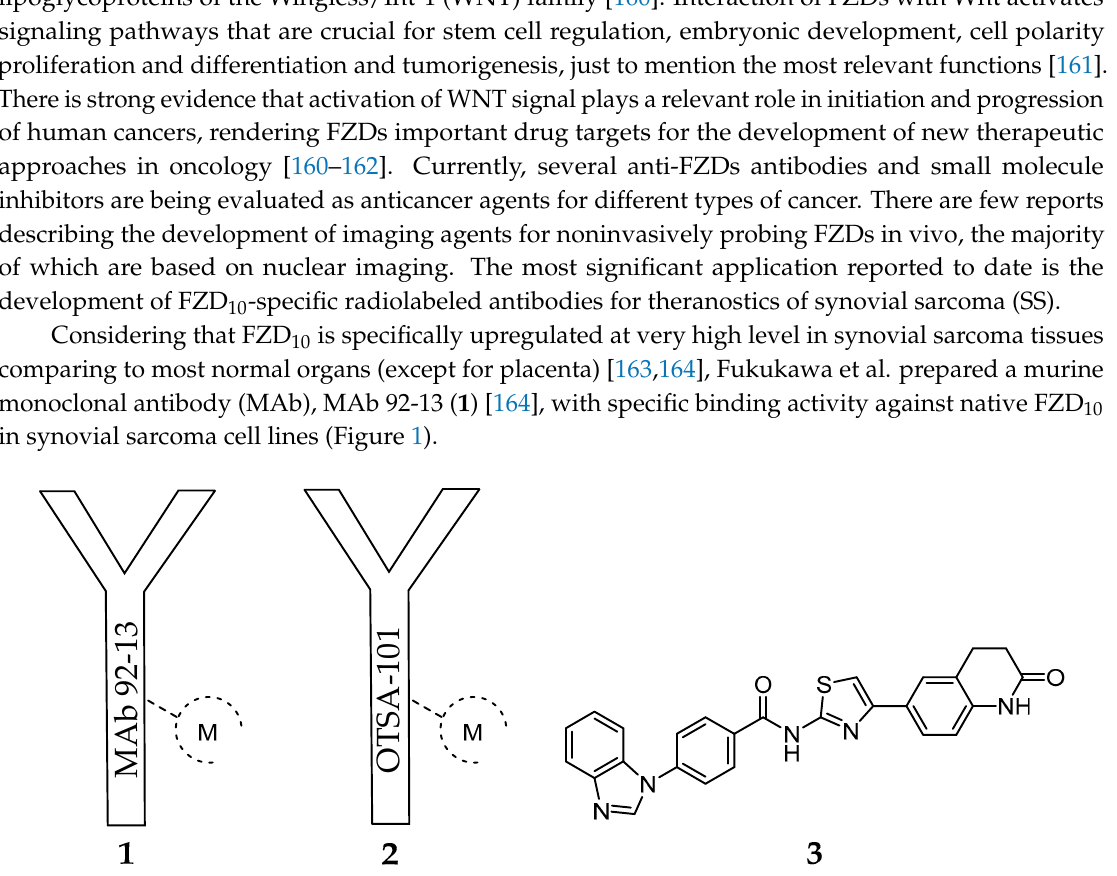
Figure 1. Frizzled receptor (FZD)-targeting molecules. MAb 92-13 ( 1 ): [ 111 In]- 1 (M = 111 In), [ 90 Y]- 1 (M = 90 Y); OTSA-101 ( 2 ): [ 111 In]- 2 (M = 111 In), [ 90 Y]- 2 (M = 90 Y). The specificity was confirmed by flow cytometric analysis with fluorescent dyes and radioactive measurement using [ 125 I]- 1 . After derivatization of 1 with the bifunctional chelator